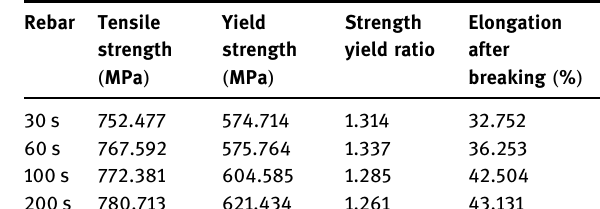
Figure 9: Stress – strain curves of the experimental rebar under the conditions of di ff erent isothermal times.